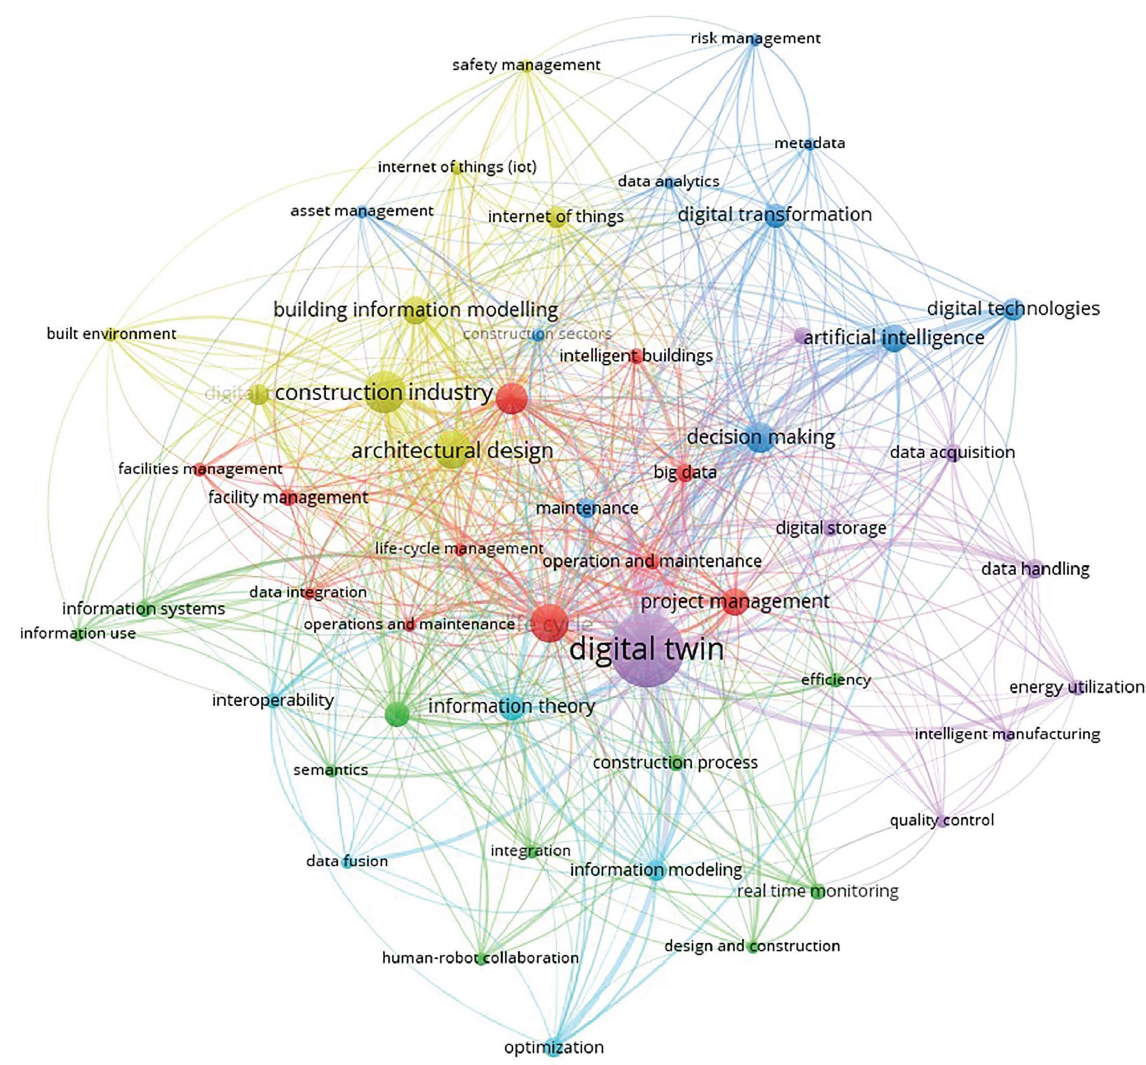
Figure 4: Network representation of keyword co-occurrence extracted from Scopus of the Digital Twin research in the AEC-FM industry from 2016 to